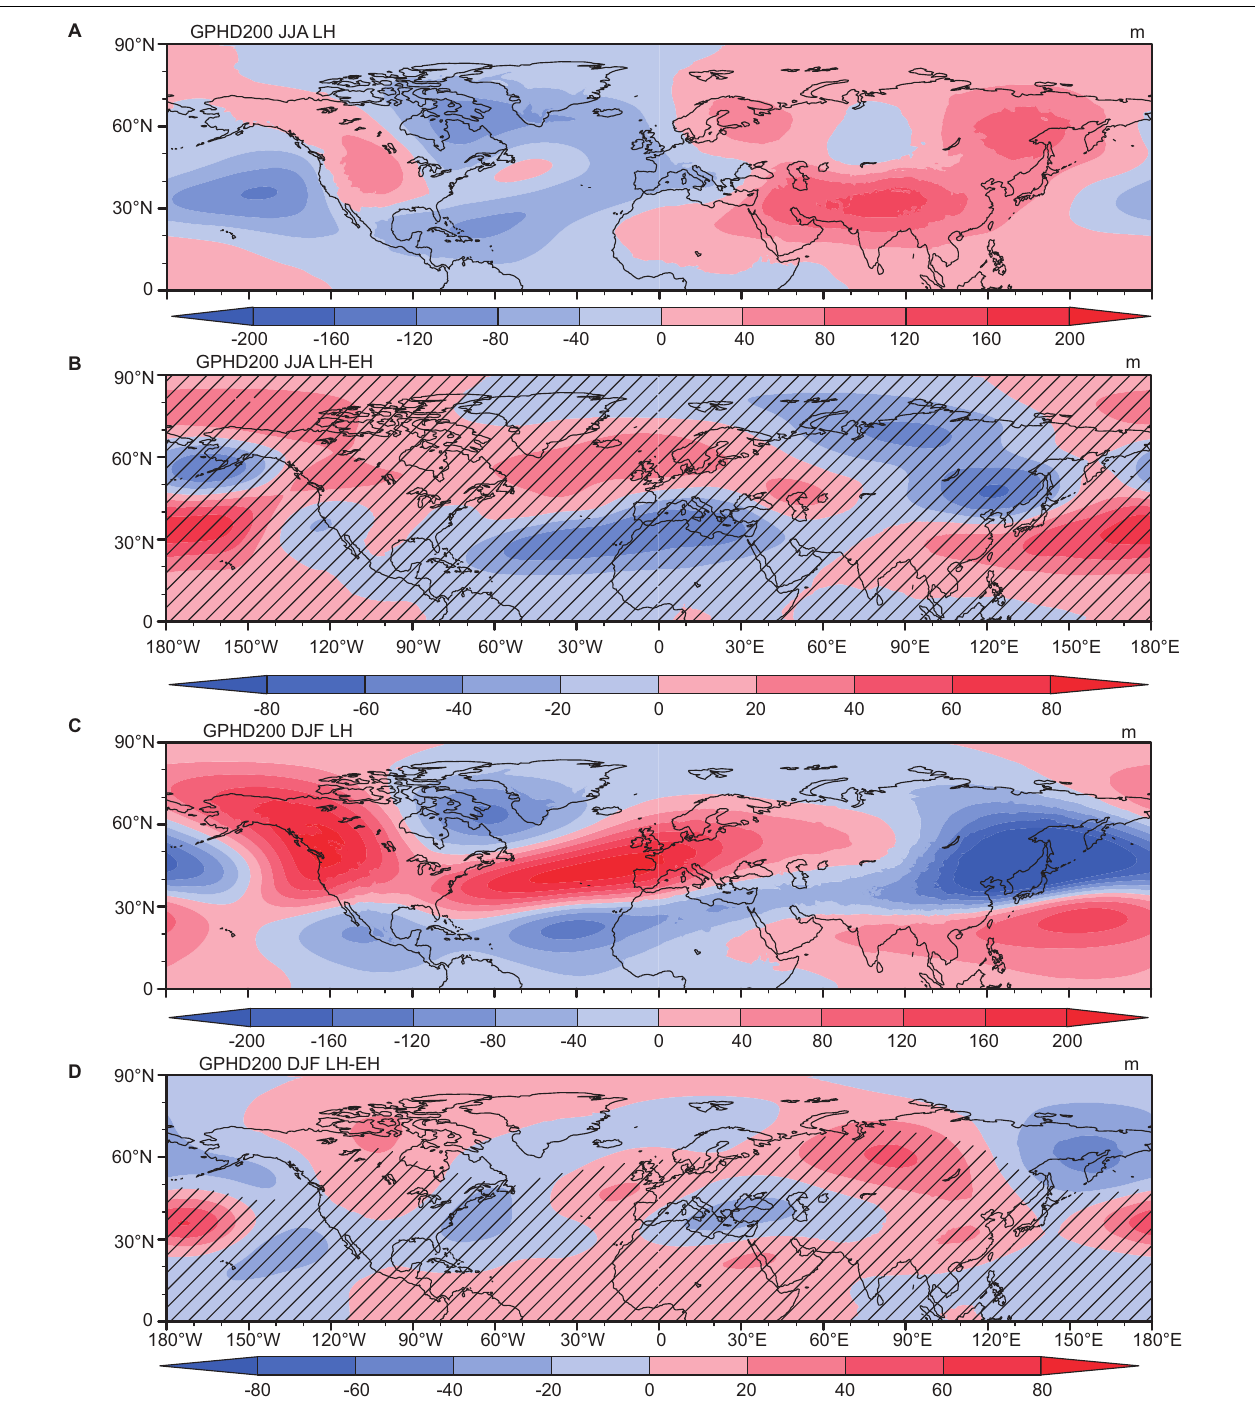
FIGURE 7 | The 200 hPa geopotential height disturbance over the Northern Hemisphere during the Holocene. Summer and winter 200 hPa geopotential height disturbance in LH (A,C) and the LH-minus-EH difference (B,D) . The line indicates the differences at the 95% significance level.